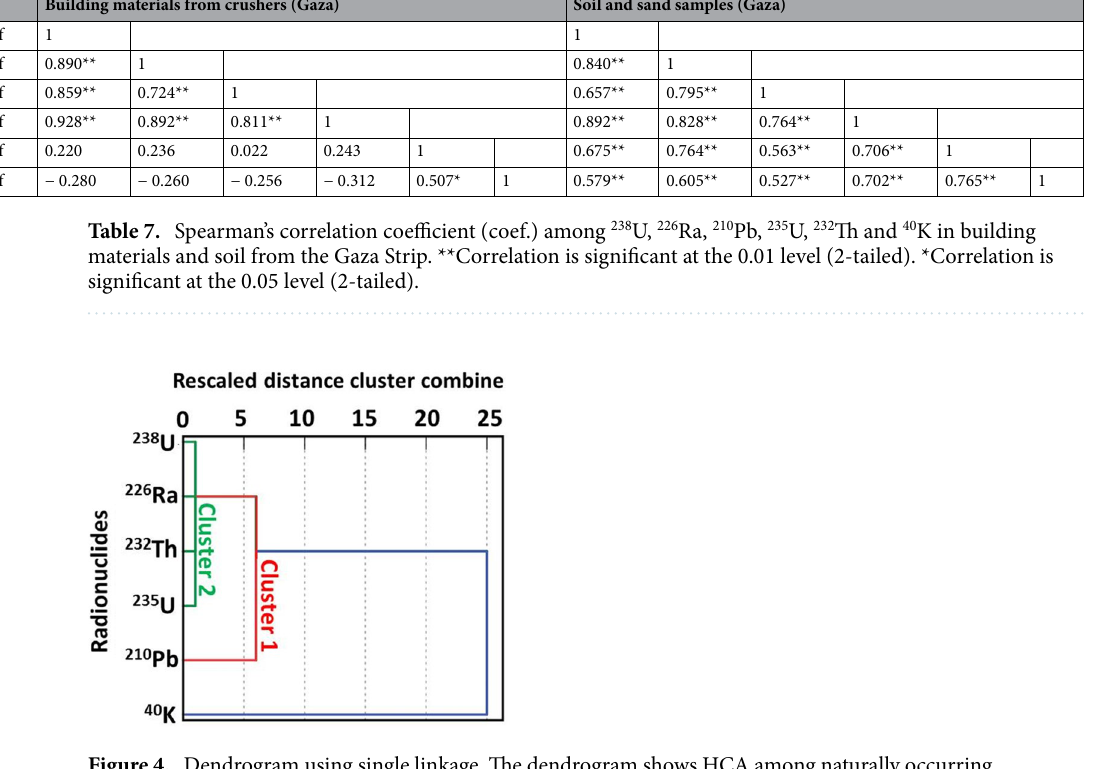
Figure 4. Dendrogram using single linkage. The dendrogram shows HCA among naturally occurring radionuclides in building materials from crushers in the Gaza